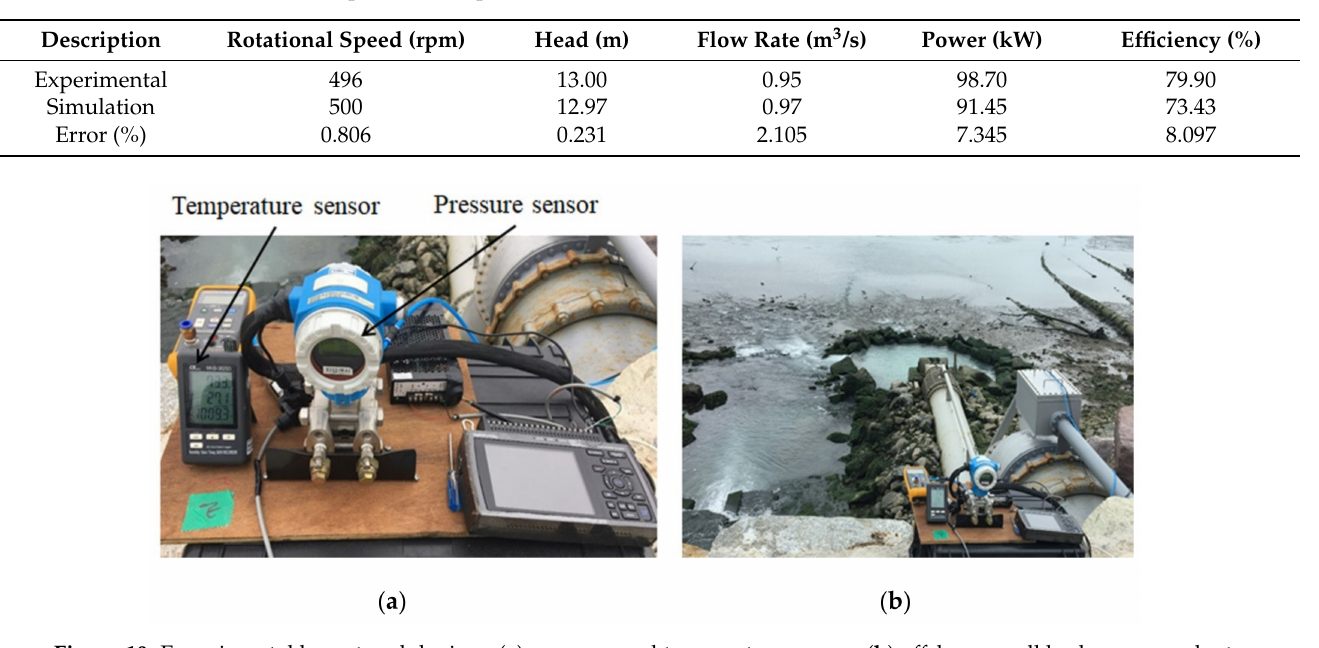
Figure 10. Experimental layout and devices: ( a ) pressure and temperature sensor; ( b ) offshore small hydro power